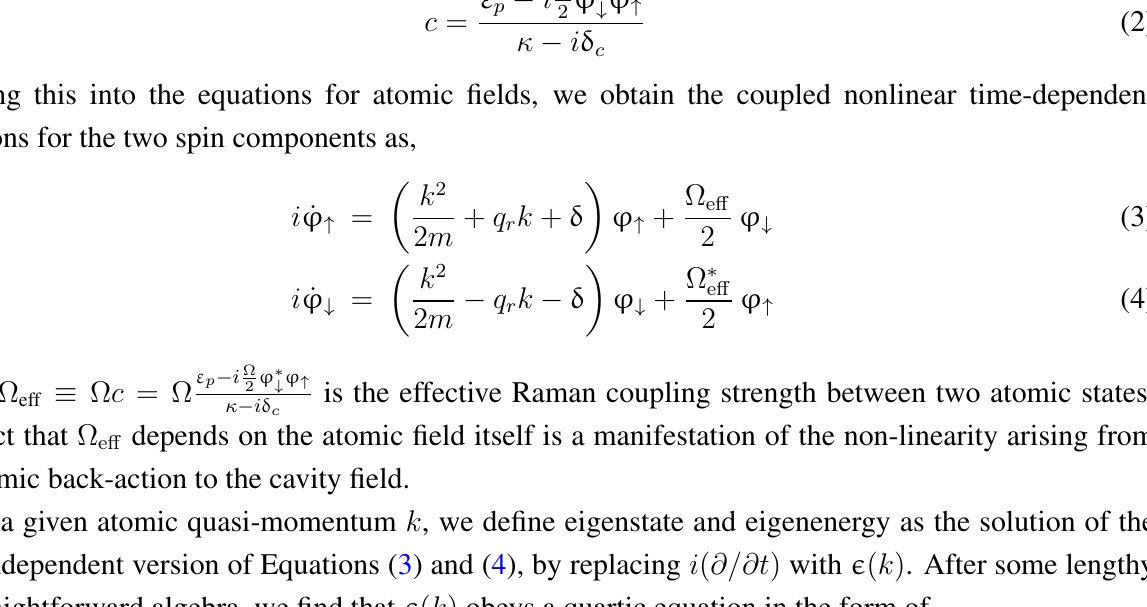
is an external coherent laser beam. ε R